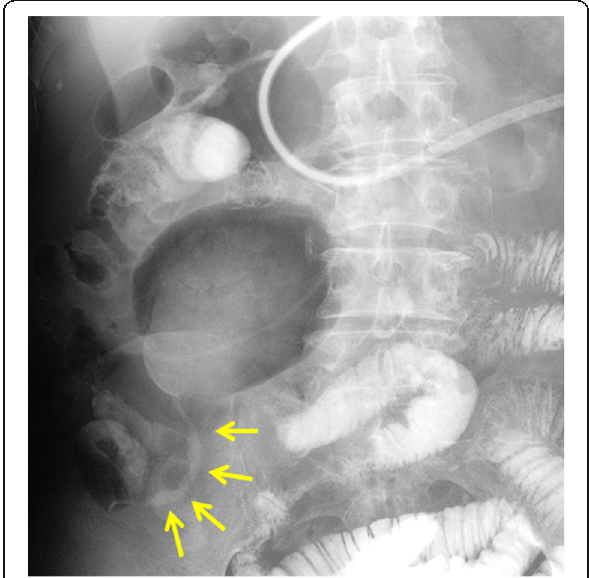
Fig. 3 Small-bowel series revealing stenosis of the small intestine (arrow) and dilation of the proximal side. The length of the stenosis was about 5 cm